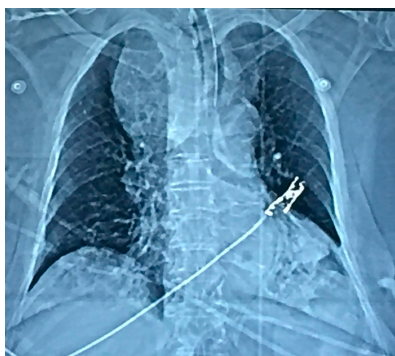
Figure 2. Chest x-ray of the patient.